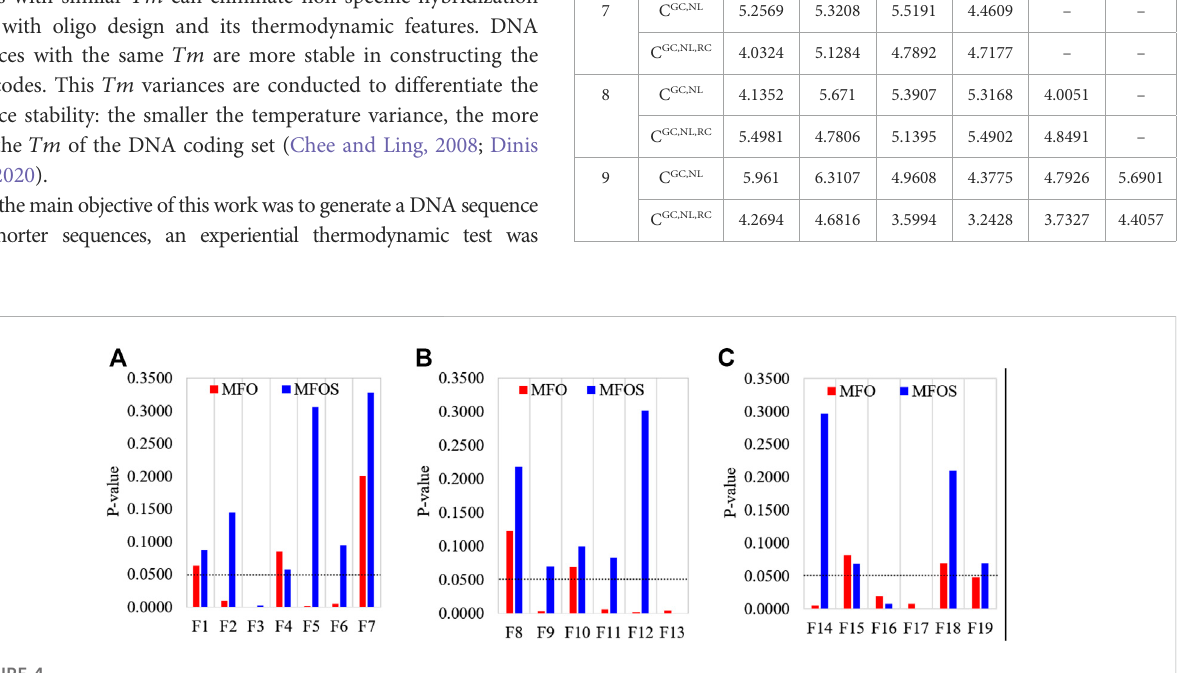
FIGURE 4 Wilcoxon rank-sum test ’ s comparison of MFO and MFOS algorithms for (A) unimodal functions, (B) multimodal functions, and (C) composite functions.